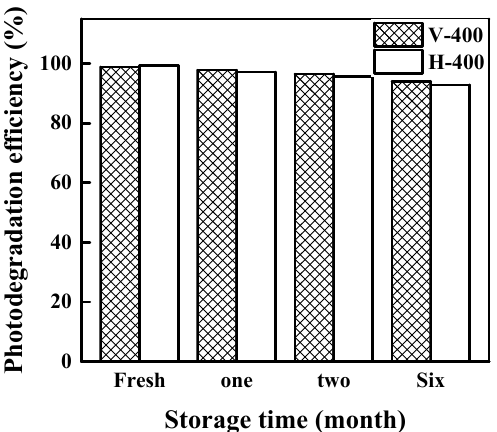
Figure 11. MB degradation efficiency by V-400 and H-400 with different storage time under AM 1.5 G solar light irradiation.